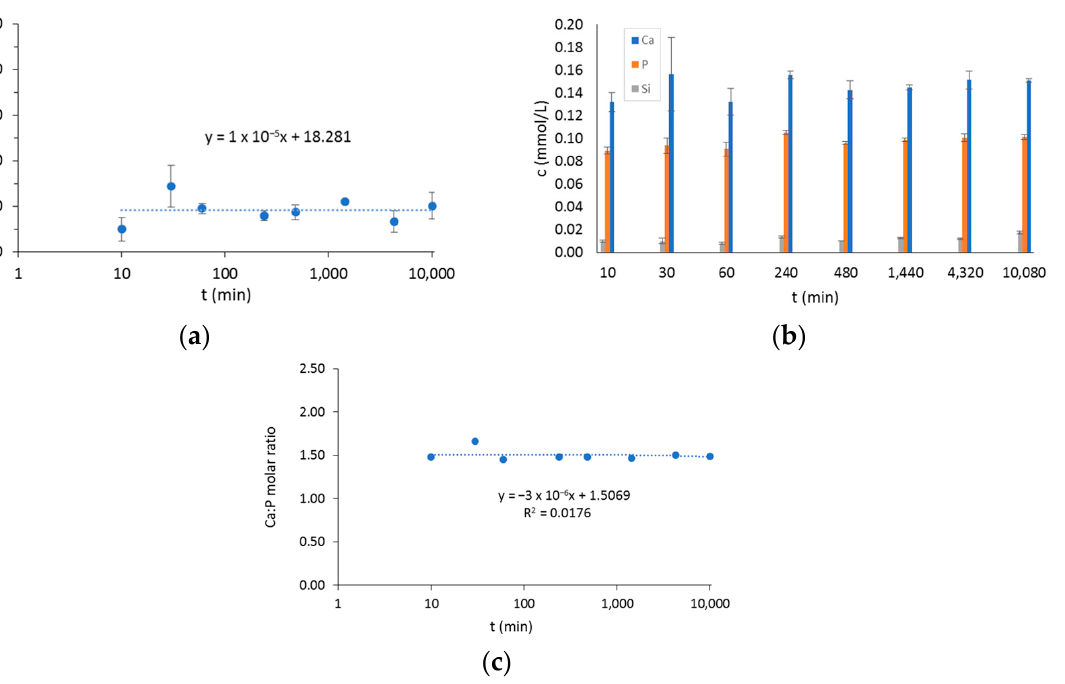
Figure 7. ( a ) The leachable part of the BTCP-AE-FM in water. ( b ) The total amount of Ca, P, and Si ions in water after soaking periods. ( c ) The molar ratio of dissolved Ca and P. The time axis is shown in log scale in plots ( a , c